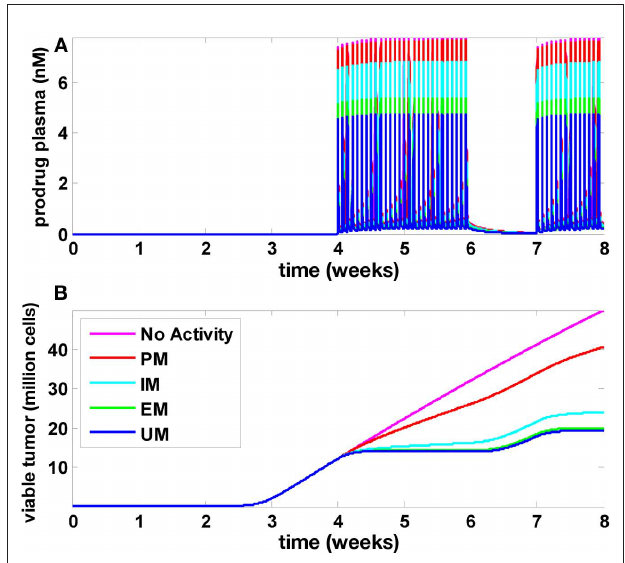
Figure 5 | Tumor development, treatment, and CYP2D6 activity influence. Time courses for the prodrug plasma concentration (A) as well as viable tumor cells (B) are shown for five different values of CYP2D6 activity. Without CYP2D6 activity (magenta), no active metabolite will be generated. Regarding tumor growth, this scenario is identical to a scenario without drug treatment. The activity differences for CYP2D6 between PM, IM, EM, and UM were derived according to Zanger et al.